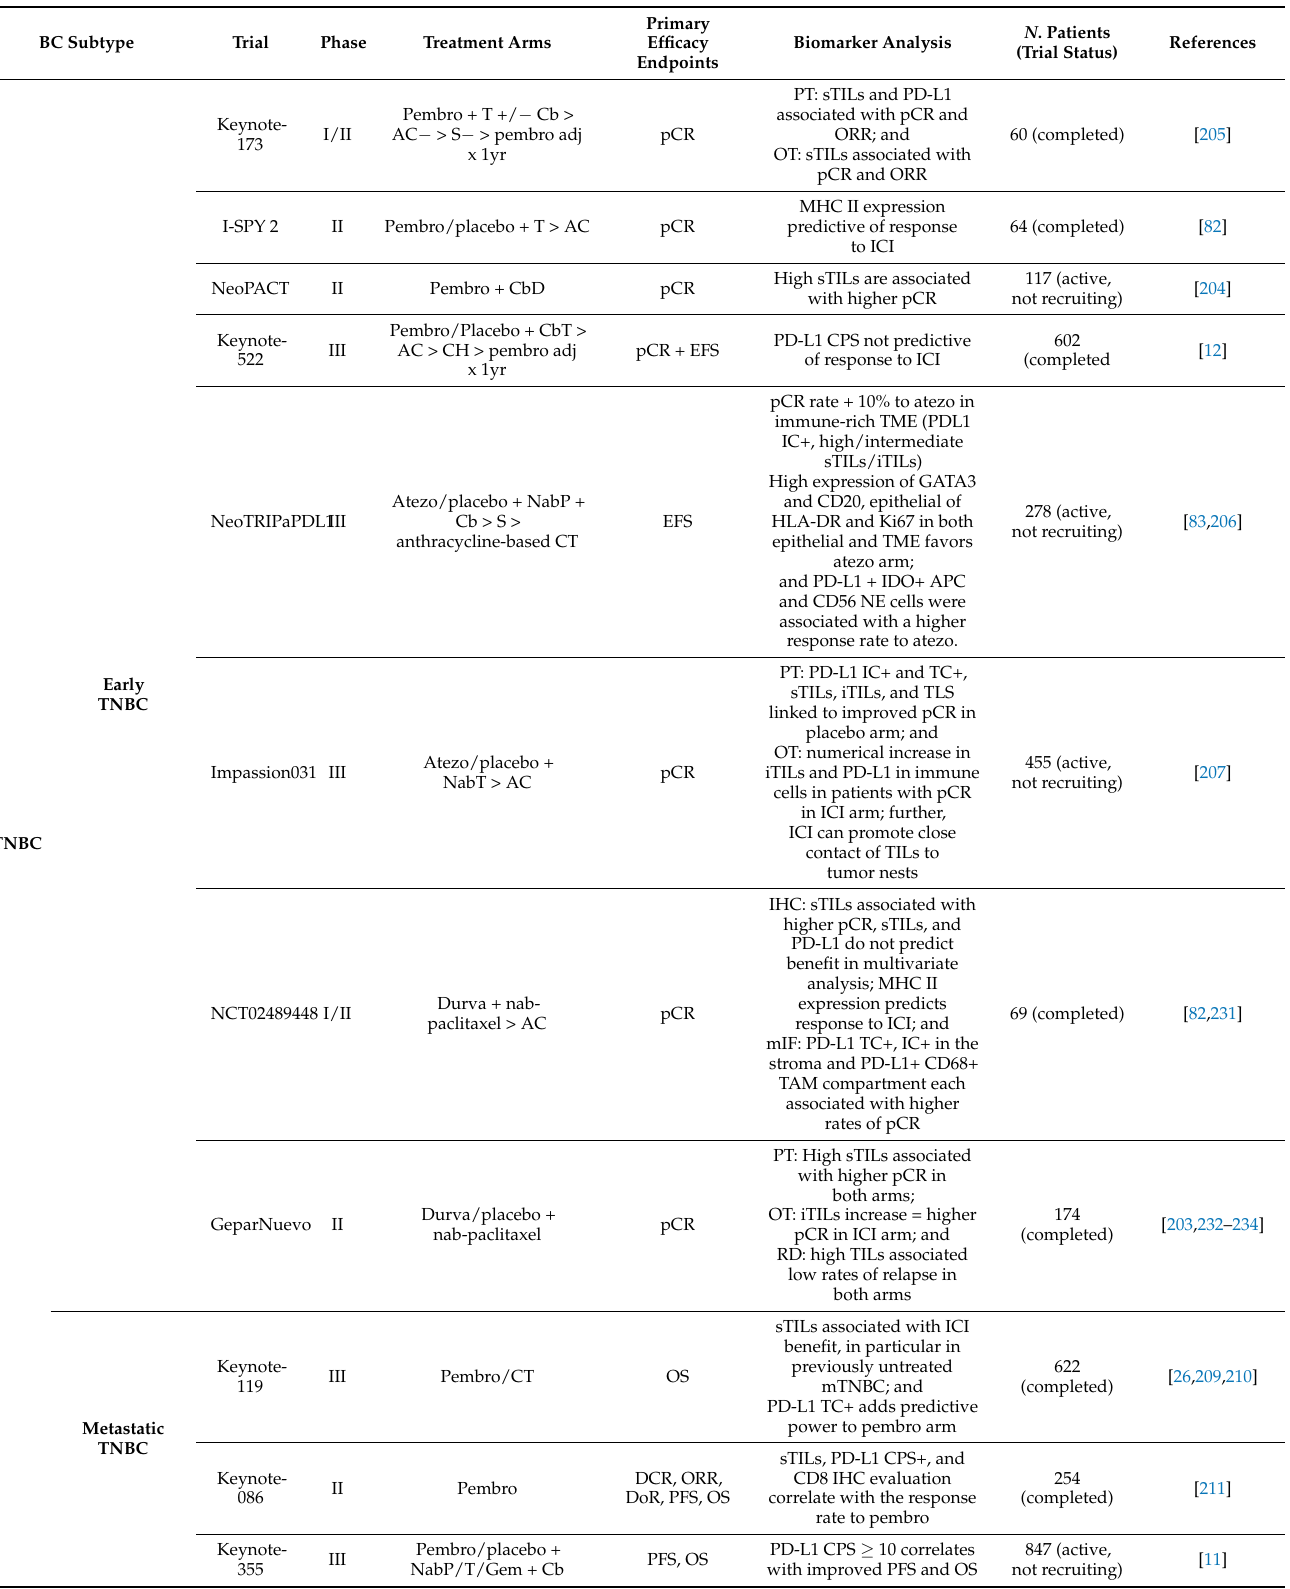
Table 1. Main clinical trials exploring ICIs’ role in